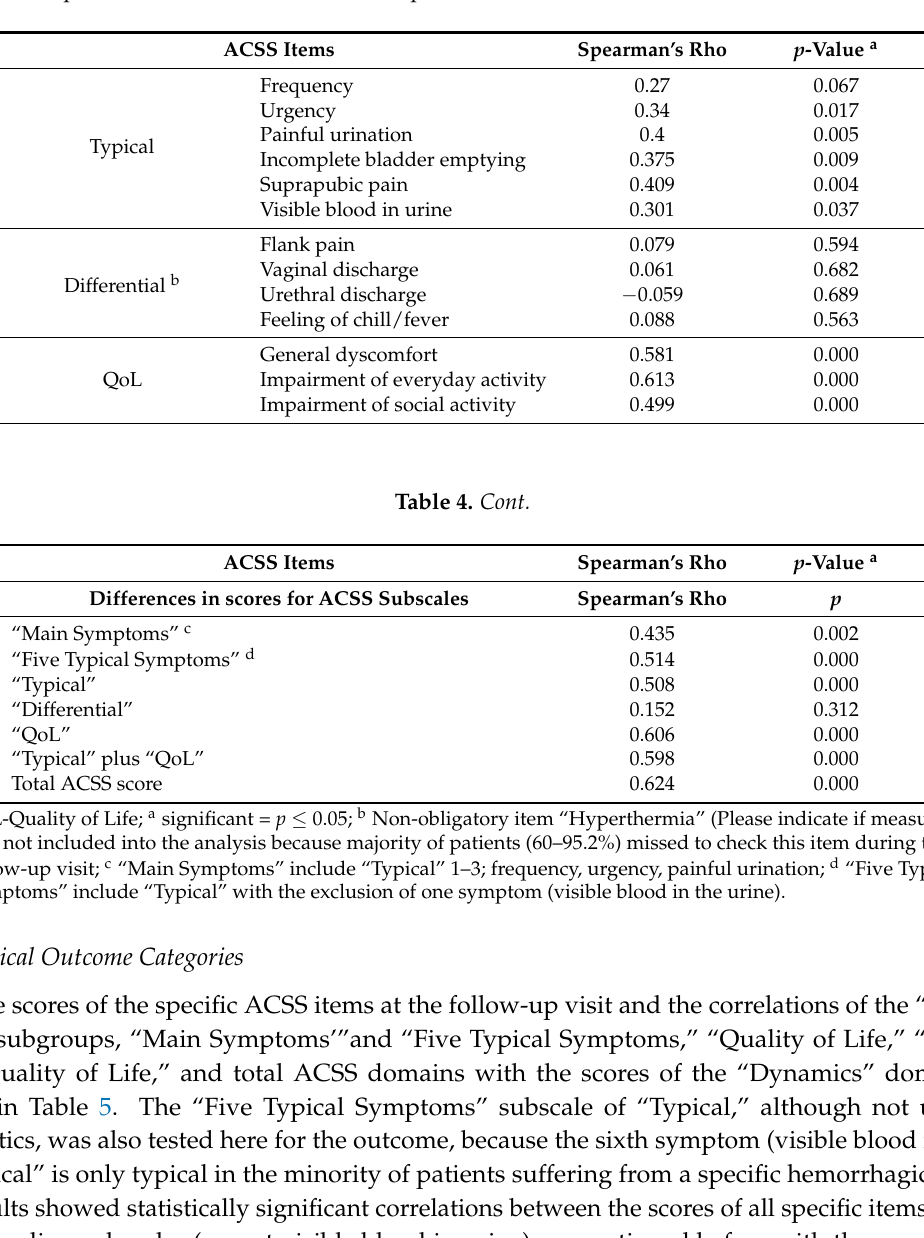
Table 4. Correlation between scores of “Dynamics” domain and differences in scores for ACSS items in 48 female patients between first and follow-up visit.